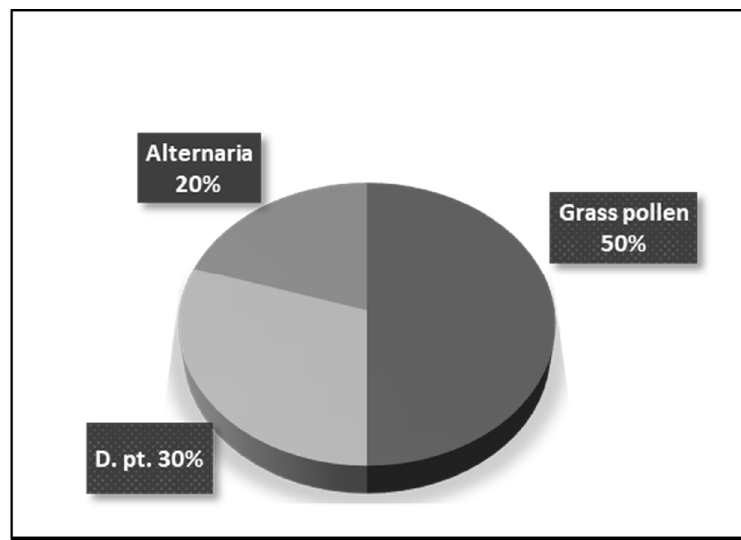
Figure 1. Specific sensitization of patients with allergic rhinitis.